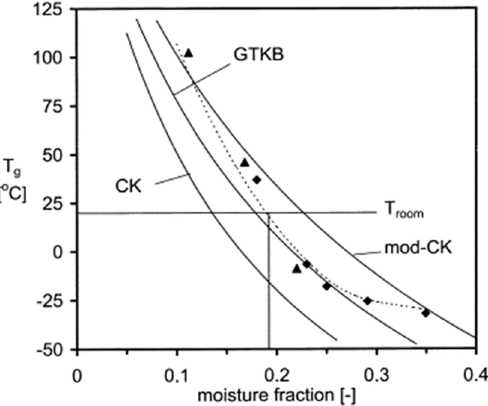
Figure 6. Variation of T g of amylodextrin with moisture fraction. Experimental data representing the glass transition as determined from conventional DSC ( ♦ ) and the reversing heat flow of modulated DSC ( ▴ ). Reprinted with permission from [44].